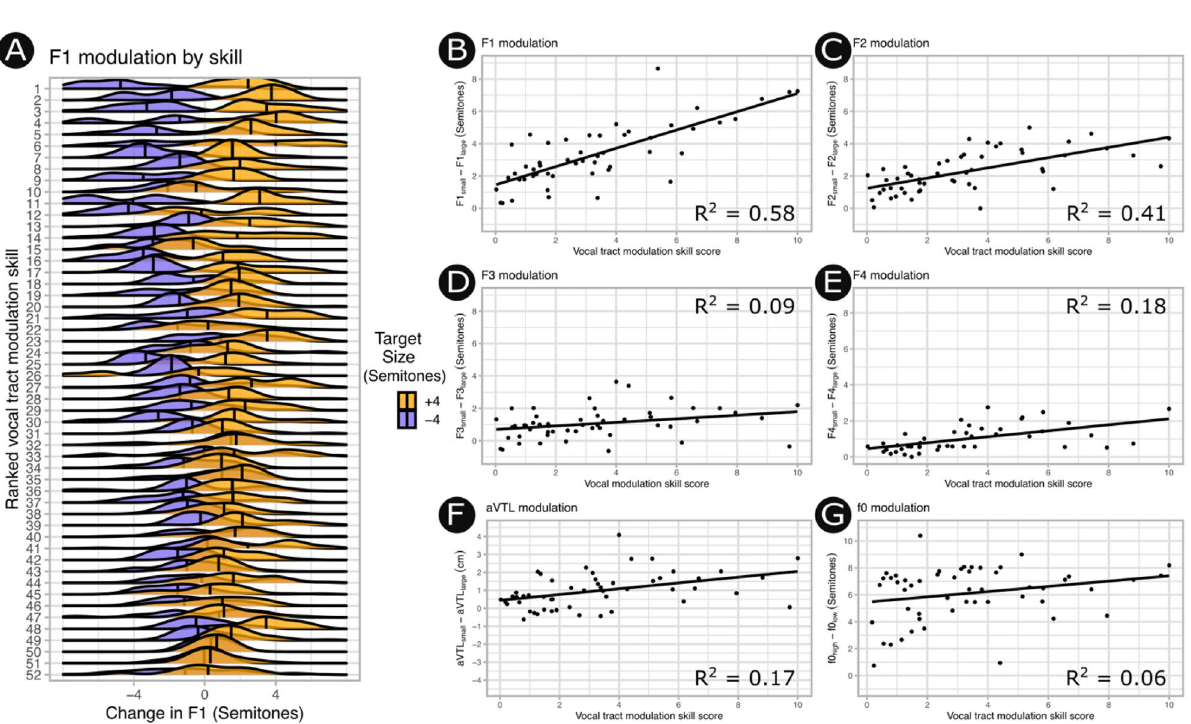
Figure 6. Modulation of speech acoustics according to vocal tract modulation skill. ( A ) Ridgeline plot showing change in F1 (x-axis) sounding small (orange) or large (purple) for each participant (y-axis). Participants are ranked in descending order according to their vocal tract modulation skill score as derived from rtMRI measurements. Larger separations between distributions for small versus large indicate greater modulation of vocal acoustics. ( B ) A strong Pearson correlation between vocal tract modulation skill as derived from rtMRI (x-axis) and acoustical modulation (y-axis) in F1 demonstrates that speakers with a greater ability to change the size of their vocal tract produced larger changes in the quality of their voice. ( C – E ) Weaker correlations are evident for the higher formants, and ( F ) correspondingly the composite measure aVTL correlates only modestly. ( G ) Vocal tract modulation skill was relatively independent from pitch matching